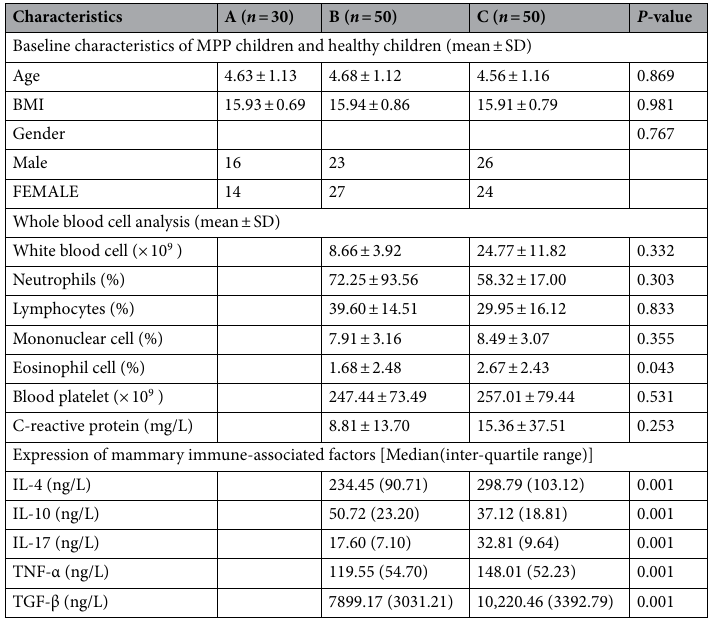
Table 1. Characteristics of subjects in the study. BMI, body mass index; MPP, Mycoplasma pneumoniae pneumonia; Interleukin, IL; TNF-α, Tumor necrosis factor-α; TGF-β, transforming growth